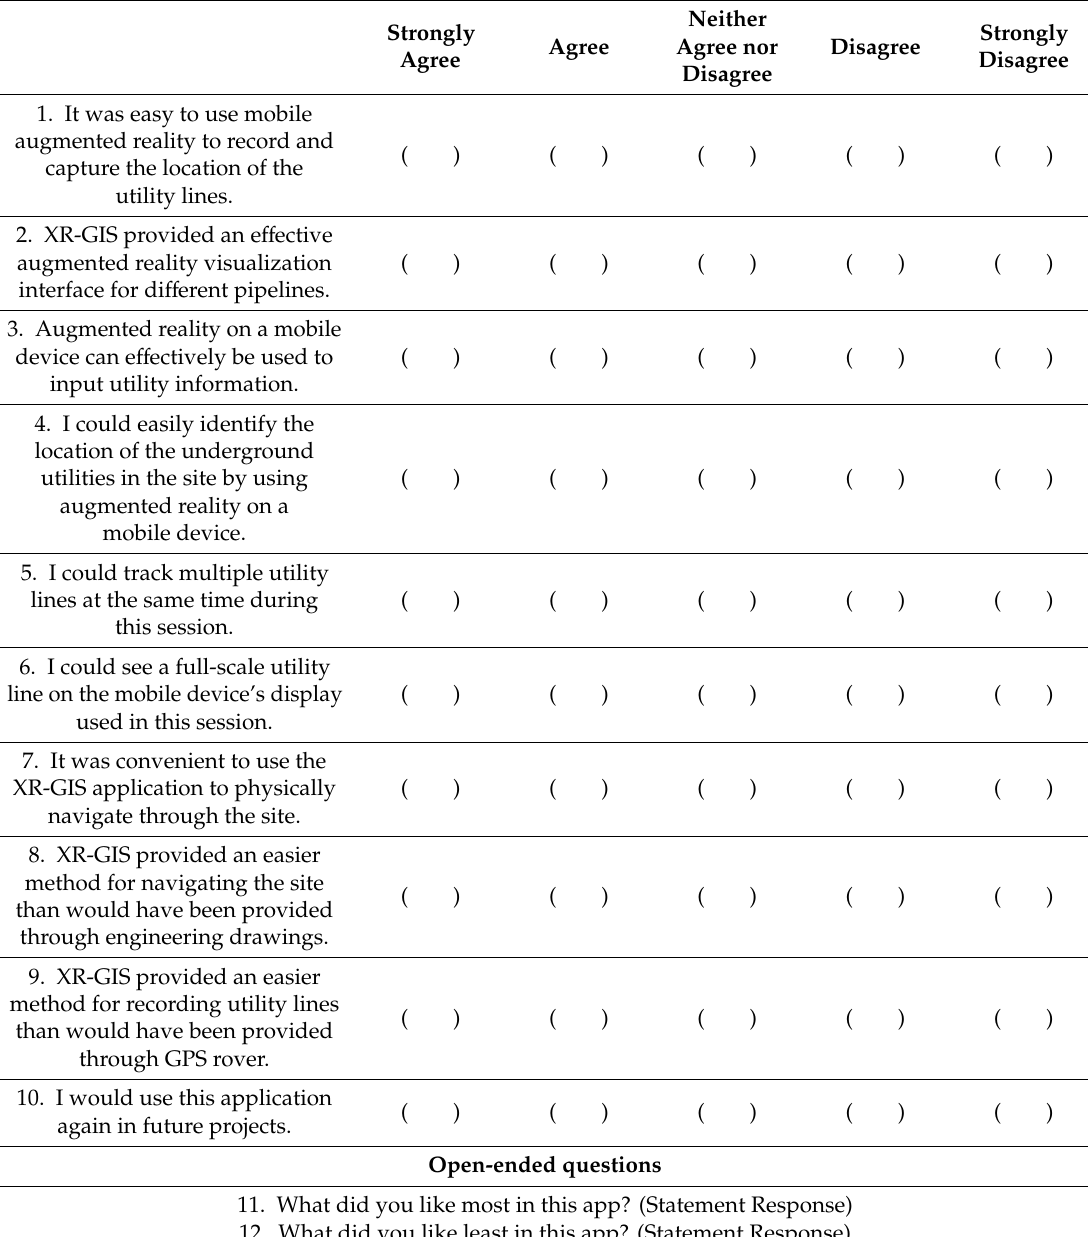
Table 2. Confirmatory focus group questionnaire. Rate Your Level of Agreement with the Following Sentences Strongly Agree